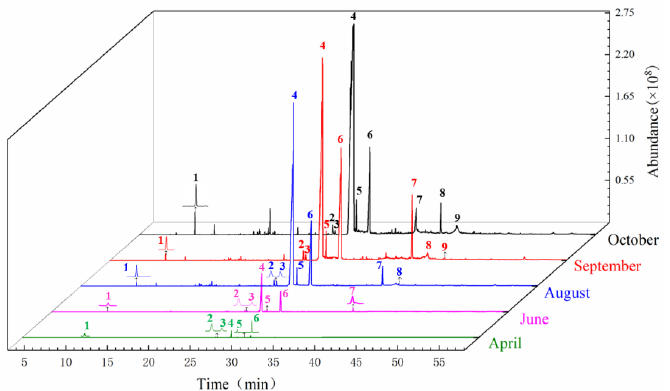
Figure 5. Changes of chemical components in the body of A. sinensis in different periods. 3.3. Analysis of Chemical Components in the Tail of A. sinensis at Different Periods The GC-MS chromatogram of A. sinensis of the tail of A. sinensis in different periods was shown in Figure 6. The chemical composition and relative concentrations were ob- tained using the peak area normalization method (Table 3).